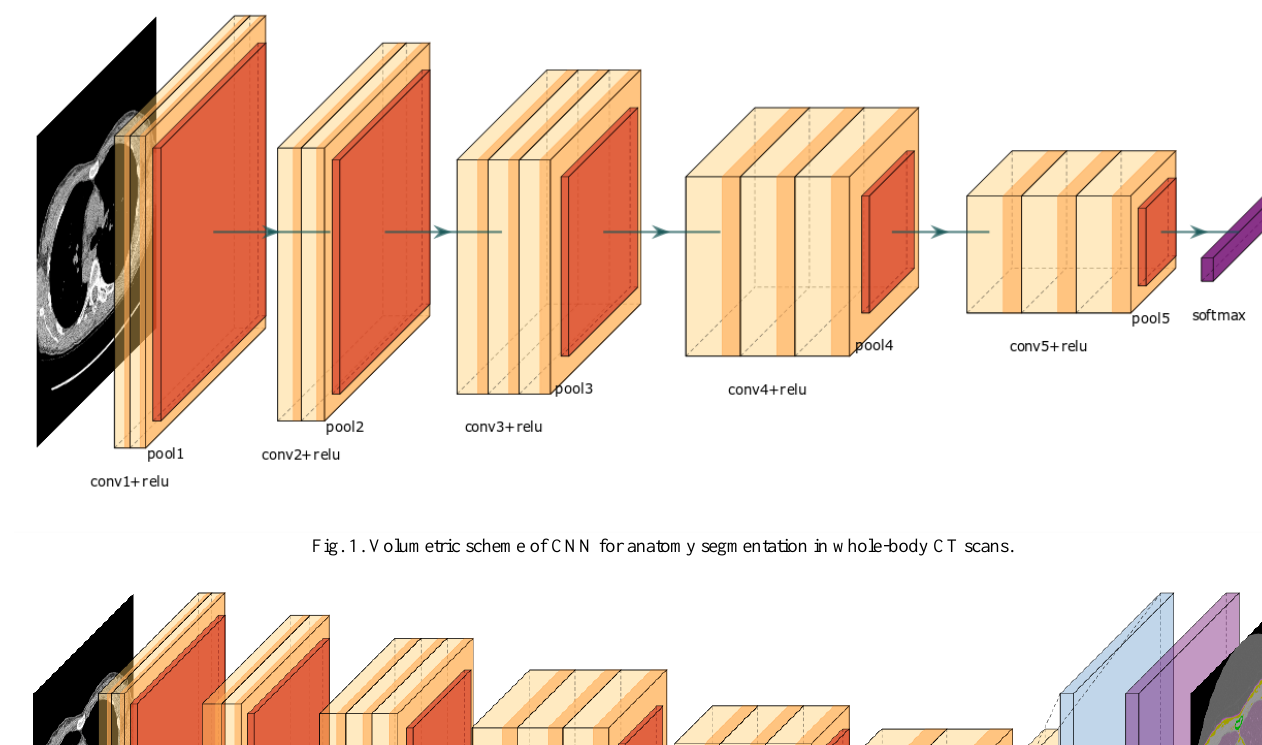
Fig. 1. Volumetric scheme of CNN for anatomy segmentation in whole-body CT scans.